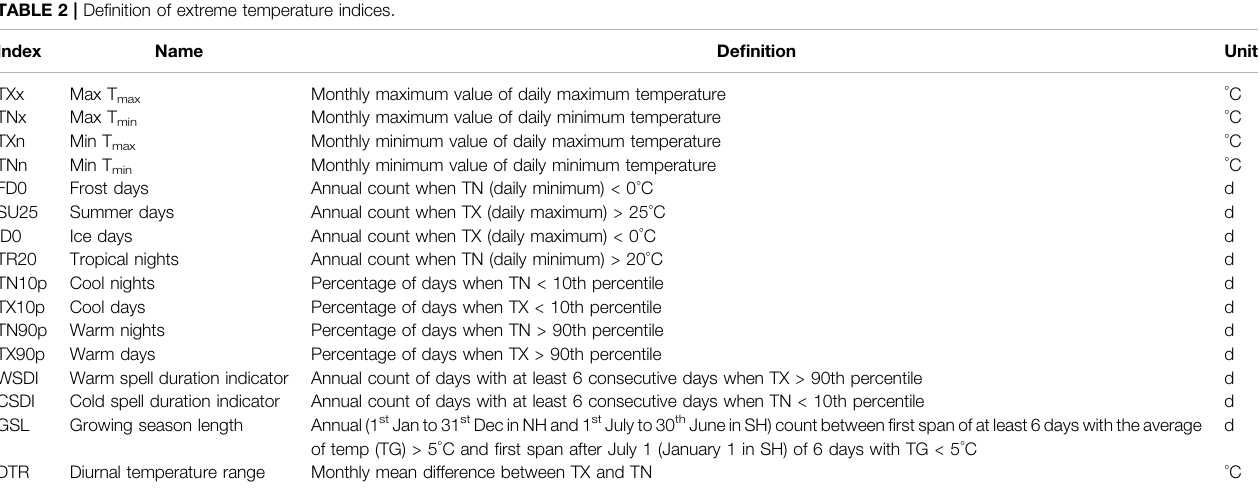
TABLE 2 | De fi nition of extreme temperature